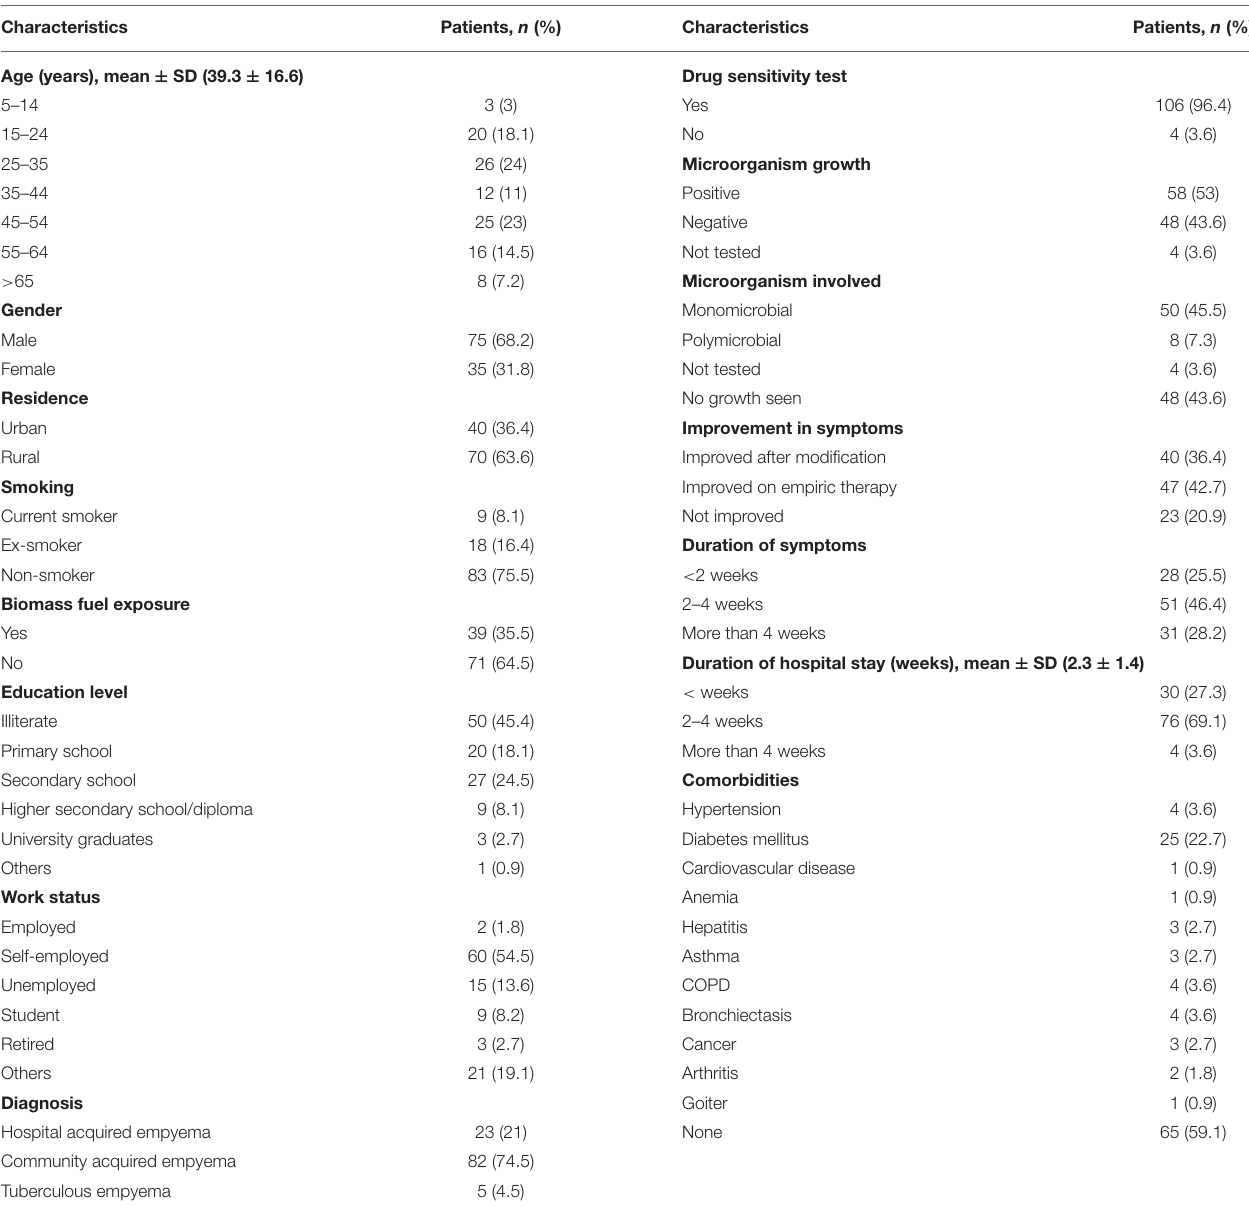
TABLE 1 | Sociodemographic and clinical characteristics of the patients ( N = 110). Characteristics Patients, n (%)